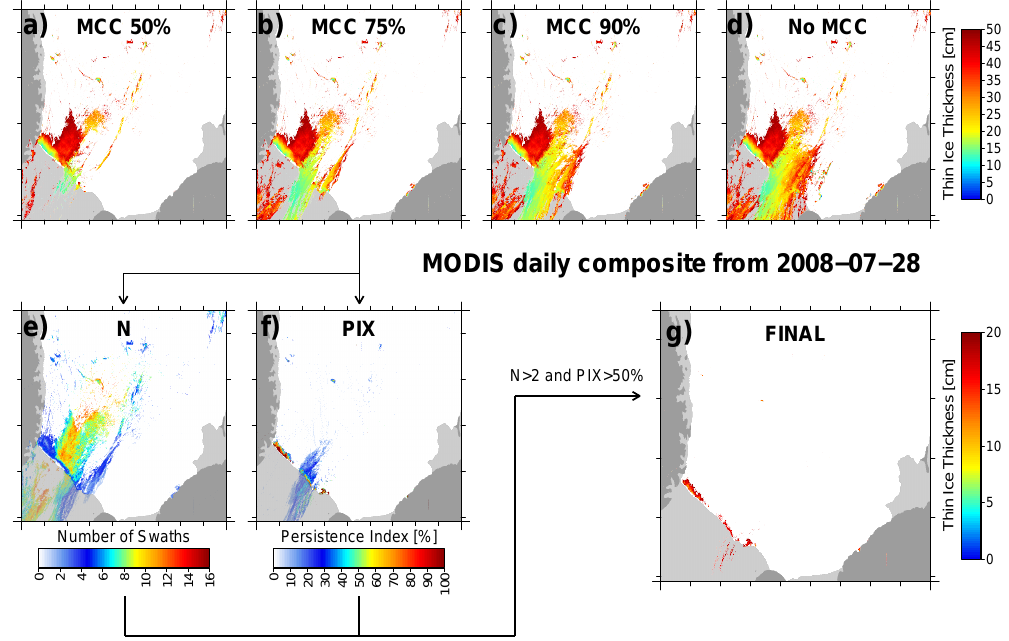
Figure 3. Effect of different ERA-Interim medium-level cloud cover (mcc) thresholds on the retrieved daily thin-ice thickness of 28 June 2008 (a–d) . Based on the 75% threshold, the number of swaths covering each thin-ice pixel (N, e ) and the resulting persistence index (PIX, f ) are presented. The finally resulting thin-ice pixels are shown in (g) .